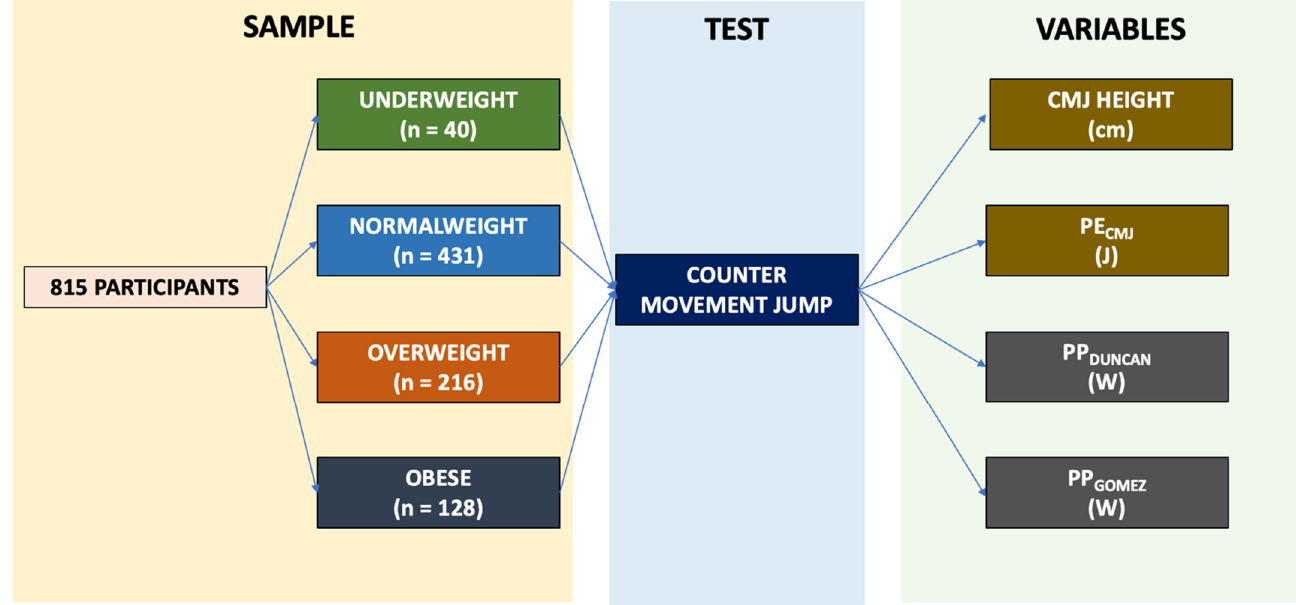
Figure 1. Flowchart of the experiment.